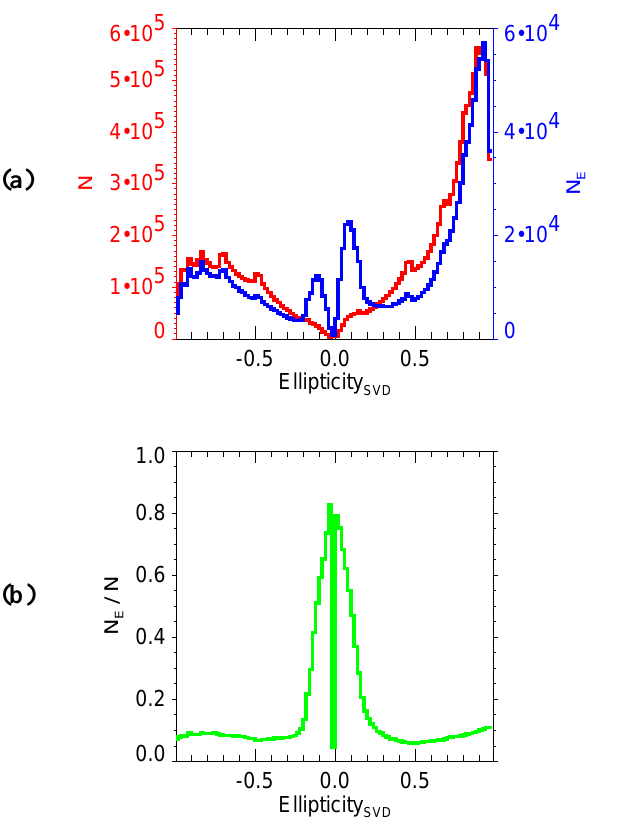
Fig. 2. Histograms of modified ellipticity L s L p (see text) deter- mined using the singular value decomposition of the magnetic spec- tral matrix. (a) Histogram of all 1.4 × 10 7 time-frequency points, plotted in red with the left-hand-side vertical scale; and of selected 1.3 × 10 6 intense events above 10 − 6 nT 2 Hz − 1 , plotted in blue, with the right-hand-side vertical scale. (b) Normalized histogram of the elipticity of the intense events.